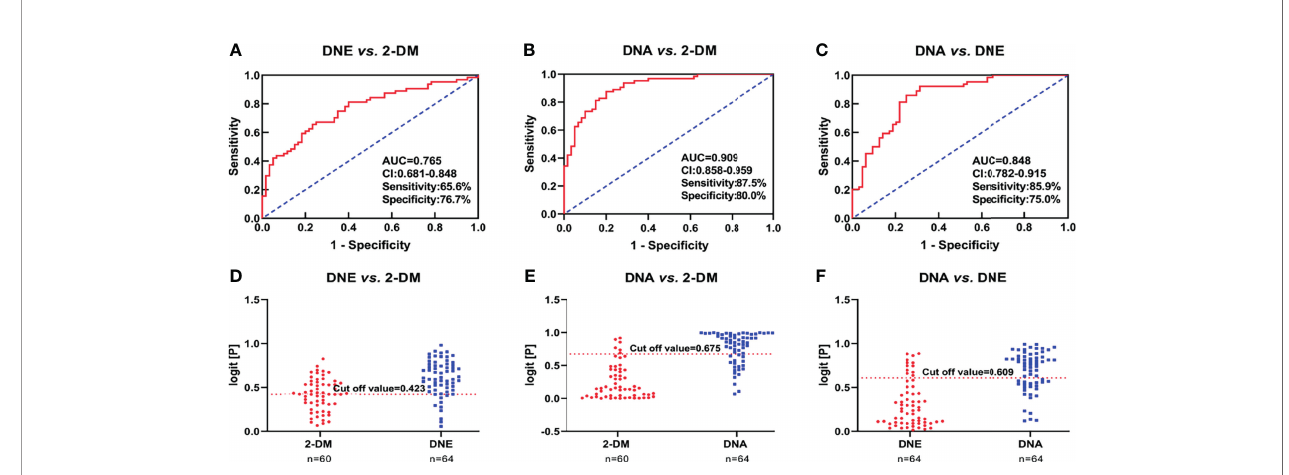
FIGURE 5 | (A – C) Receiver operating characteristic curve analysis (ROC) in combination with LPE(16:0) and TAG54:2-FA18:1 to discriminate HCs, 2-DM and DN patients in the Validation Set. (D – F) Prediction accuracies of the panel of biomarkers (LPE(16:0) and TAG54:2-FA18:1) in the Validation Set. The area under the curve (AUC) is given at 95 % con fi dence intervals. AUC, area under the curve; CI, con fi dence